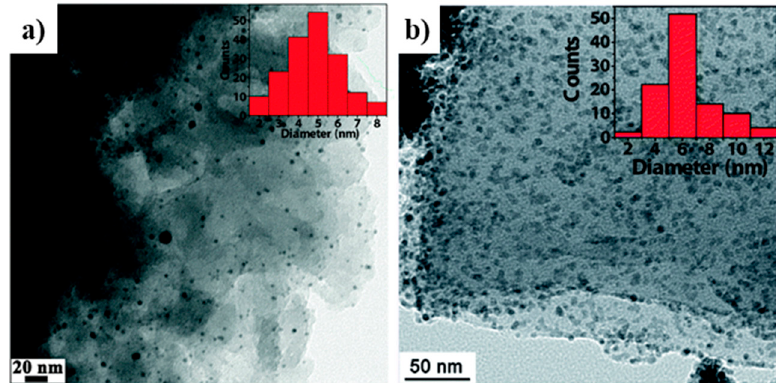
Figure 8. TEM images of ( a ) Au NP-TpPa-1 [56] and ( b ) Pd NP-TpPa-1 [57] composites. Inset image: NP size distribution histogram. (a) Reproduced from [56] with permission from The Royal Society of Chemistry. ( b ) Reproduced from [57] with permission from The Royal Society of